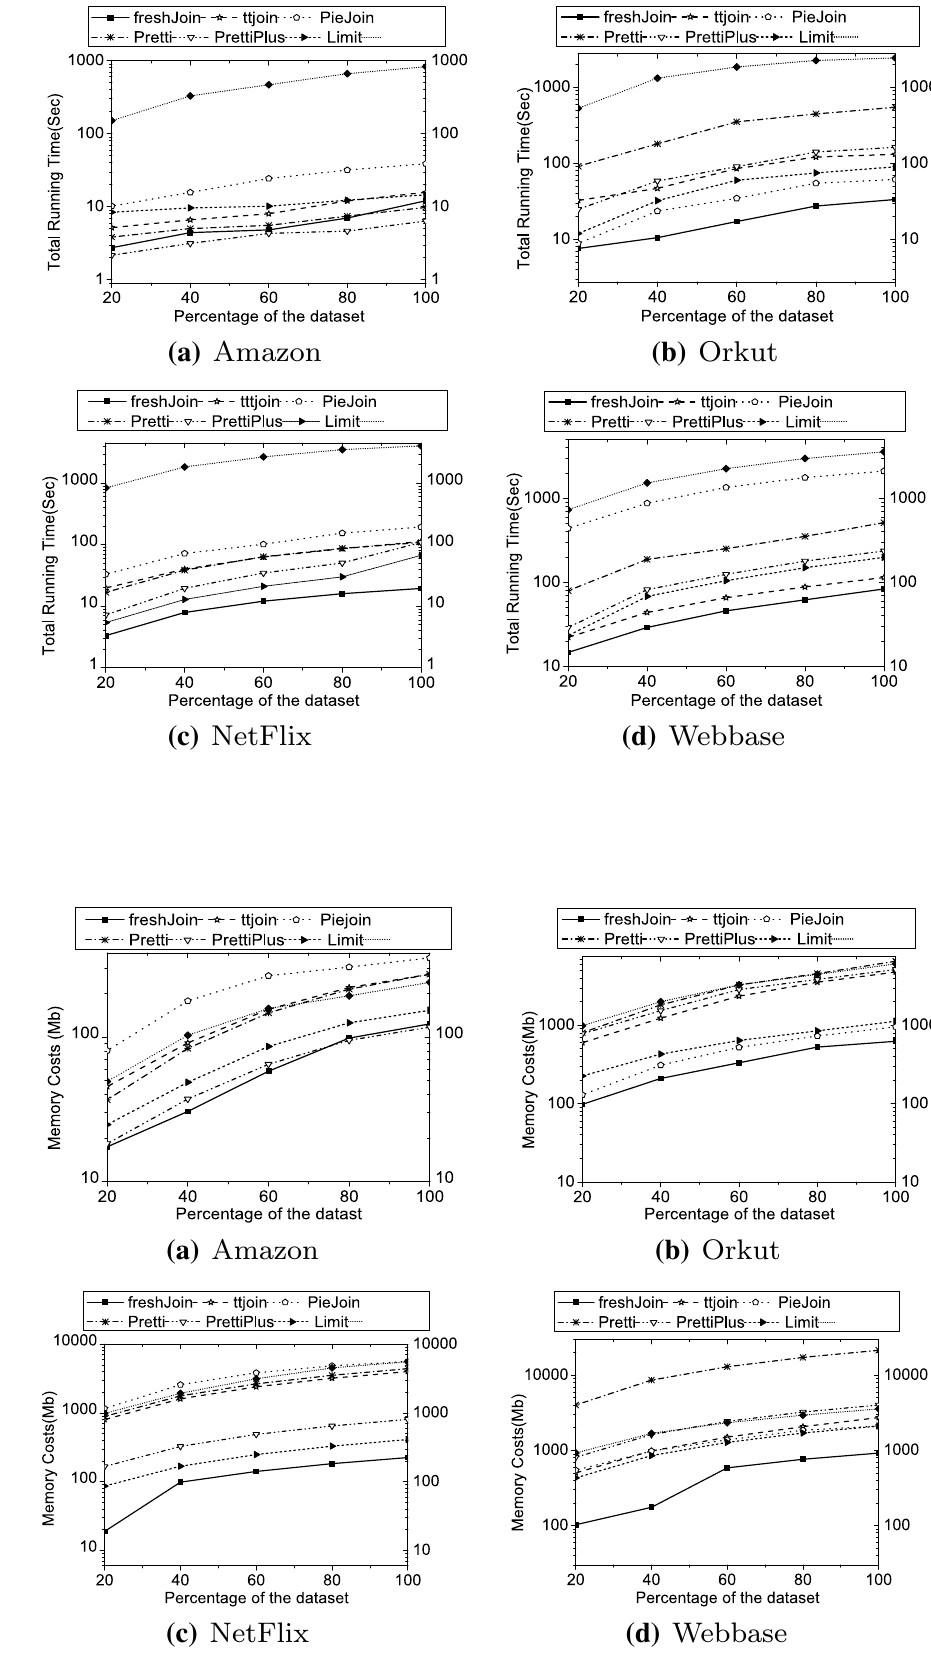
Fig. 8 Scalability in total run-